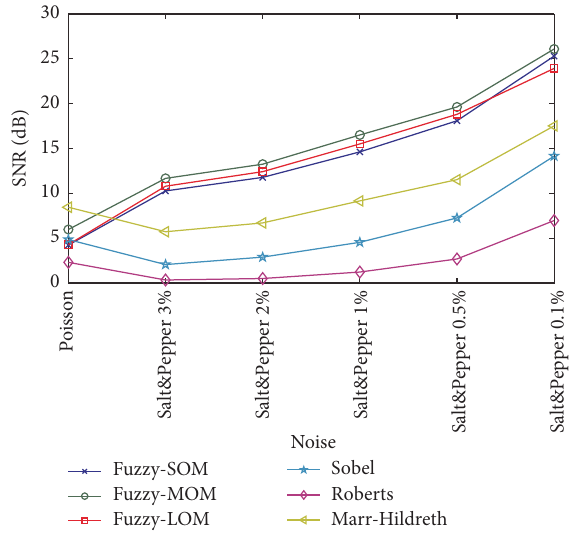
Figure 13: SNR in dB using different artificial noise (Lena’s image as